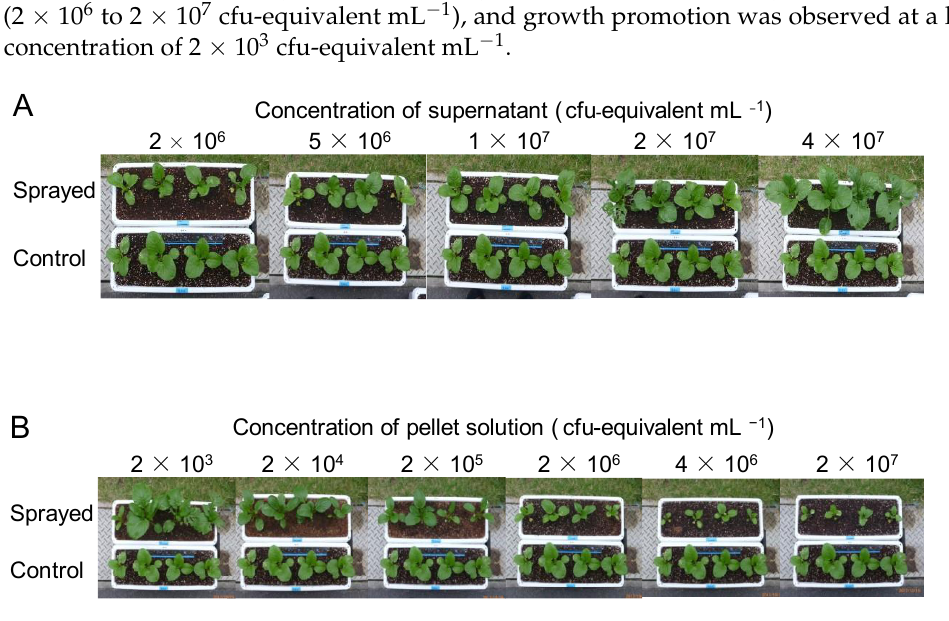
Figure 3. Plants (komatsuna) cultivated for 30 days. ( A ) Upper: plants sprayed with supernatant at each concentration. ( B ) Upper: plants sprayed with pellet solution at each concentration. ( A , B ) Lower: control (without supernatant or pellet solution).